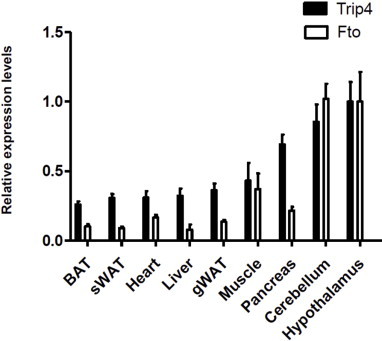
Relative mRNA levels for Trip4 (black bars) and Fto (white bars) were determined by quantitative RT-PCR in a tissue panel of WT mice fed standard chow. n = 5–6 for each tissue. Each mRNA was normalised too housekeeping gene B2M mRNA and data presented as a ratio to the expression in the hypothalamus, the tissue with highest expression of both Trip4 and Fto.